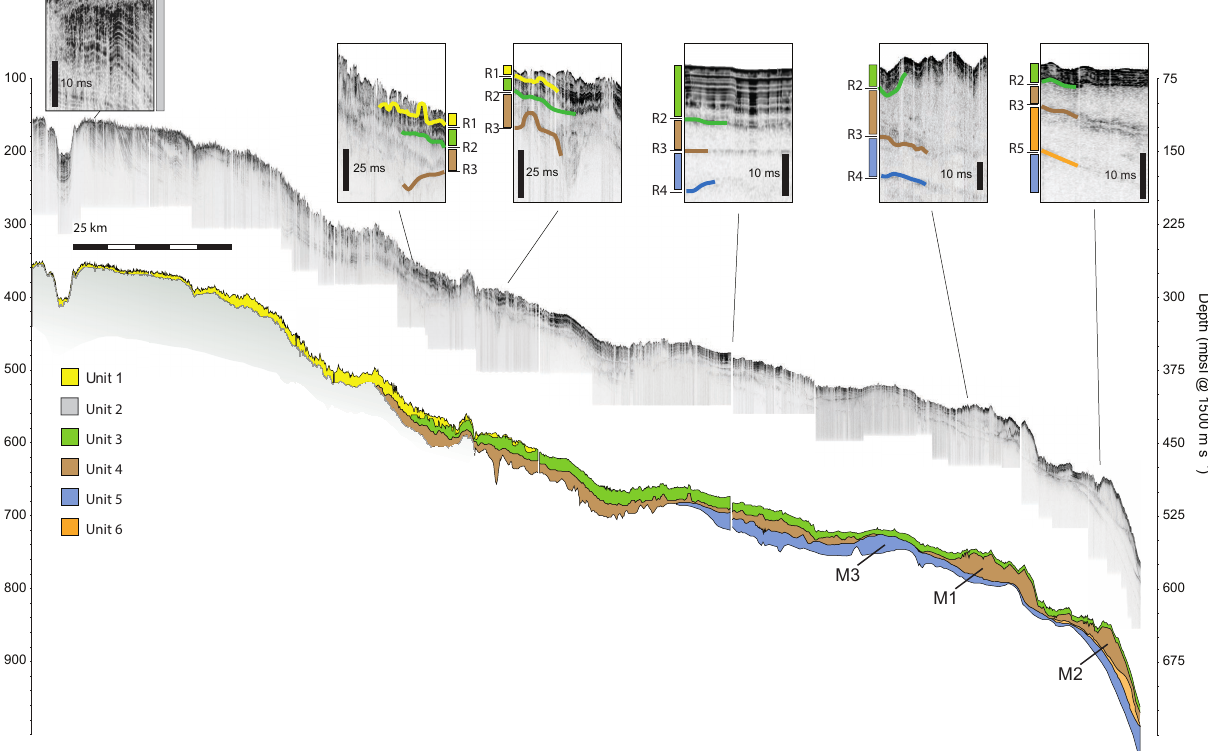
Figure 4. Composite chirp sub-bottom profile from the shallow East Siberian shelf to the shelf break at ∼ 500mb.s.l. Depths are interpreted using a constant seawater velocity of 1500ms − 1 . An interpreted profile with six acoustic units is shown below the sub-bottom data; it is offset by 200msTWT (two-way travel time) from the true depth. Details of the acoustic units and traced reflectors are shown in detailed images. Acoustic Unit 1 transitions into an acoustically laminated and undisturbed drape of sediment (Unit 3) below ∼ 260mb.s.l. The location of the profile is shown in Fig.